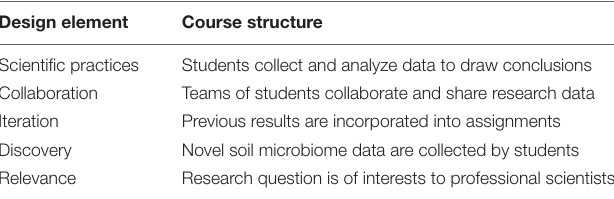
TABLE 1 | CURE design elements.